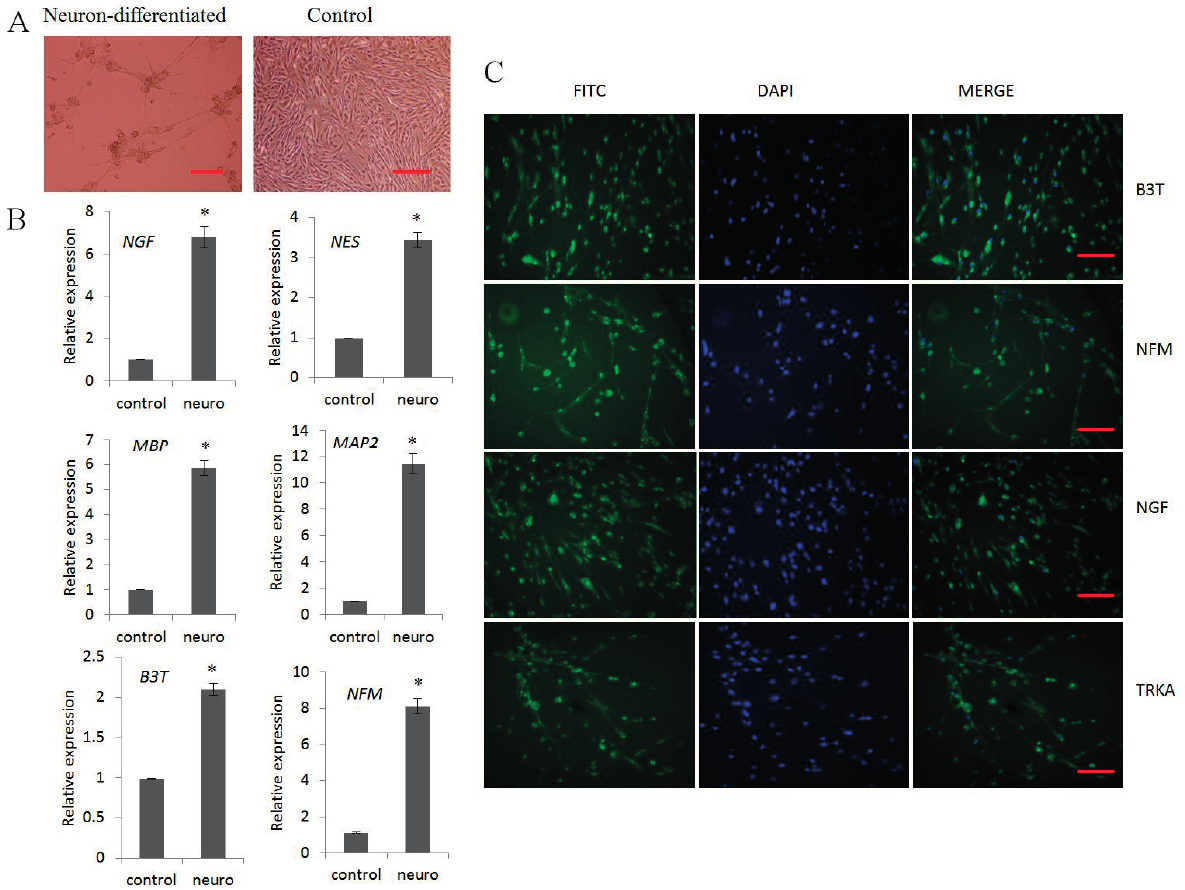
Figure 3. In vitro differentiation of porcine EMSCs into neuron-like cells. ( A ) Morphological changes after two days of induction compared to untreated control cells; ( B ) RT-qPCR analysis of neurogenic specific transcripts NGF , NES , MBP , MAP2 , B3T , NFM showed significantly higher expression in induced cells compared to non-induced EMSCs control cells; and ( C ) Immunofluorescence analysis showed positive expression of B3T, NFM, NGF, and TRKA in neuronal induced cells which were absent in non-induced control cells. DAPI indicates the nucleus and MERGE indicates the positive expression of protein, FITC conjugated IgG secondary antibody. Scale bar = 100 μ m. (* indicates significant differences ( p < 0.05) in expression of mRNA between neuronal differentiated cells and untreated control EMSCs.). HMBS was used for